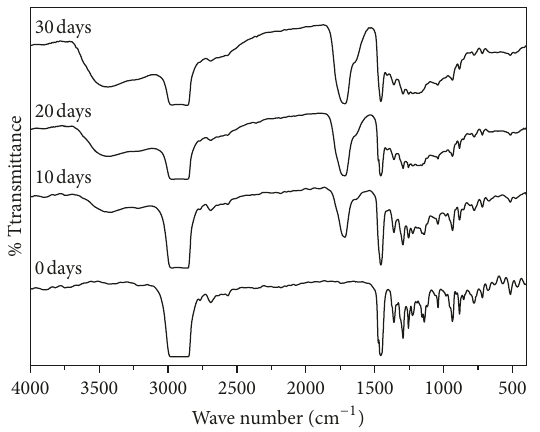
Figure 3: Change in IR of COC 6013 neat film during photoirradi- ation.